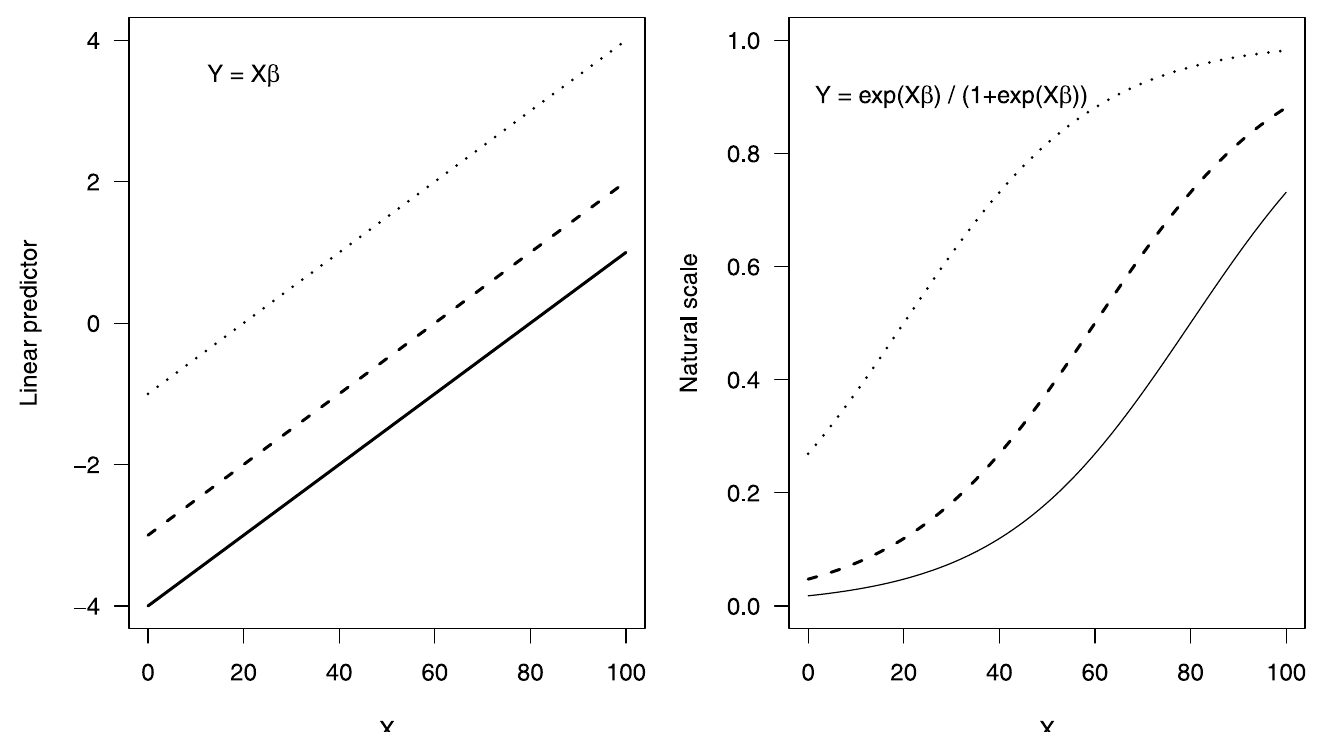
Fig 1. An example of induced iterations in GLM with main effects only. The linear predictor (left panel) shows constant difference between the three lines. On the natural scale (right panel), we see varying distance between the three lines, which is an interaction induced by the back-transformation of the logit model. Here, the solid line is β = 1; the dashed line is β = 2; and the dotted line is β = 3.